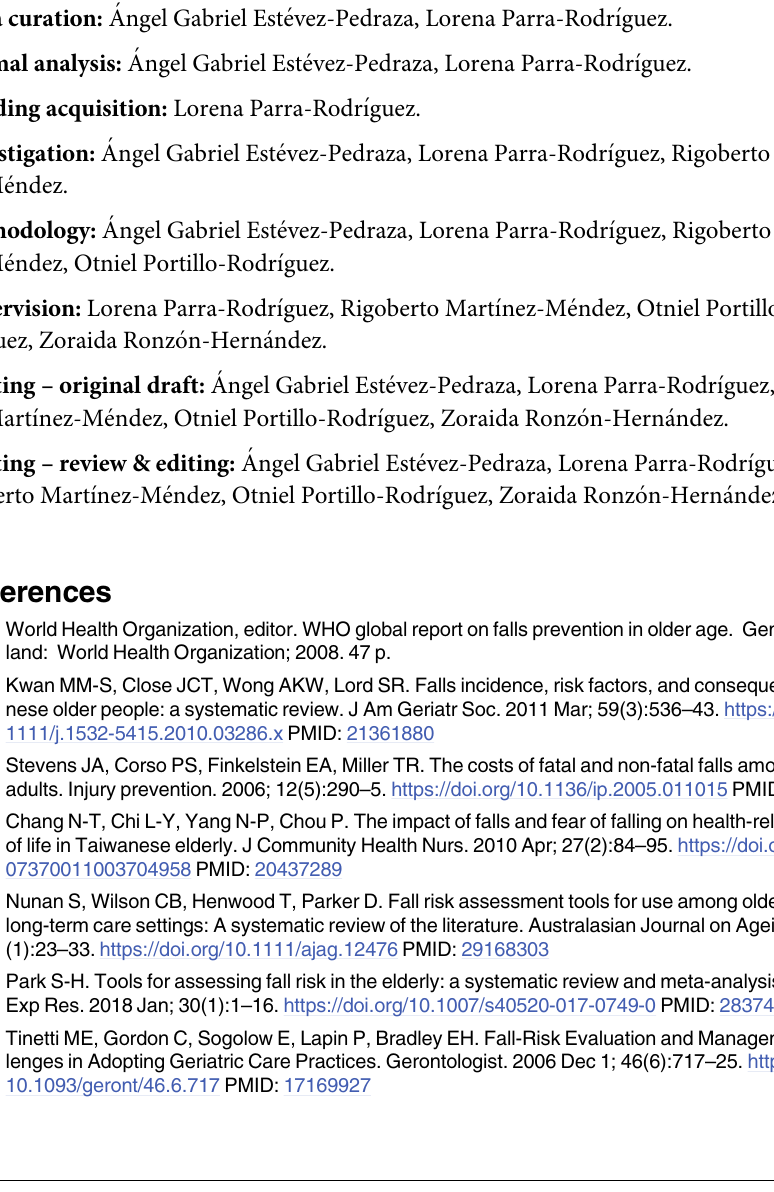
S1 Table. Complete list of the center of pressure (CoP) indexes performance respect to bal- ance